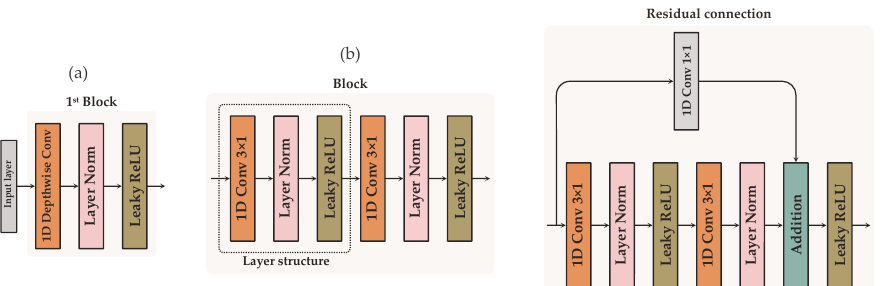
Figure 2. Detailed representation of the three types of blocks employed in the feature extraction network: ( a ) first block, ( b ) the last block, and ( c ) blocks with residual connections. Residual connections (Figure 2c) are introduced from the second block d = 2 to the block number d = D − 1 to maintain data flow throughout the network and avoid gradient degradation during training. Prior to addition, 1 × 1 convolution is used on the residual connection to equalize the number of feature maps between the layers. The number of filters increases by a factor of 2 in every subsequent residual block. Abstraction of the most significant features is performed with max pooling at the end of blocks d = [2 : D − 1], whereas global average pooling is implemented to finalize the last block d = D of the feature extraction network. To avoid overfitting, dropout with a probability of 0.25 is applied after feature